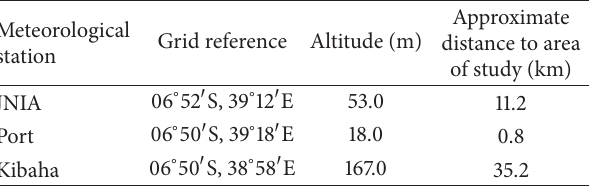
Table 1: Climate measuring stations in Dar es